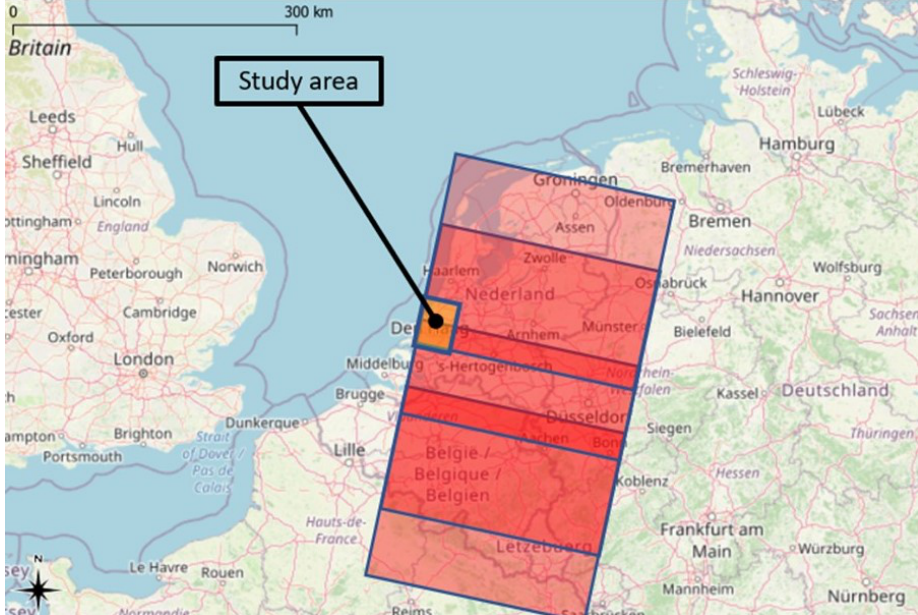
Figure 2. Footprint of the selected descending Sentinel-1 (DSC37) over the Netherlands, with the study area